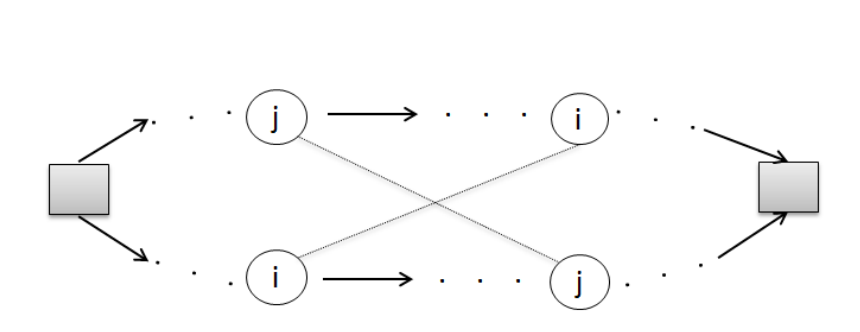
Figure 4. Contradictory positions of clients i and j